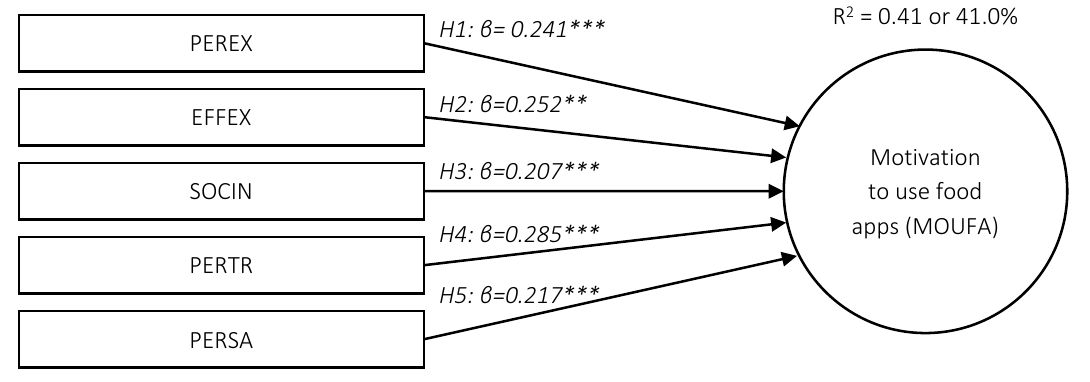
Figure 2. Regression results